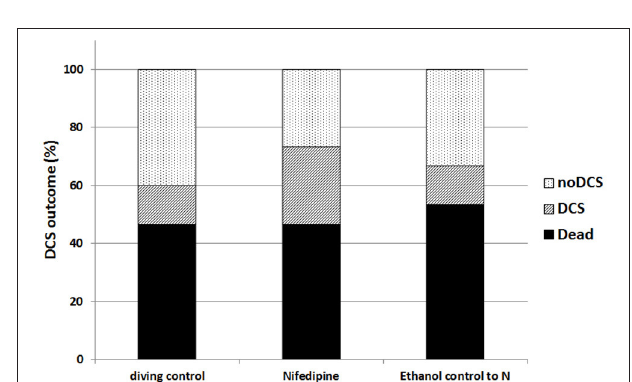
FIGURE 2 | Appearance of DCS among control rats, additional control alcohol group and rats treated with nifedipine. Appearance of DCS among the control rats, additional control alcohol group and rats treated with nifedipine expressed as a percentage of the total number of the rats in each group. Histogram in black represents the rats suffering severe DCS, stripes are rats with mild DCS and dots are the asymptomatic group. There was no statiscally significant difference between